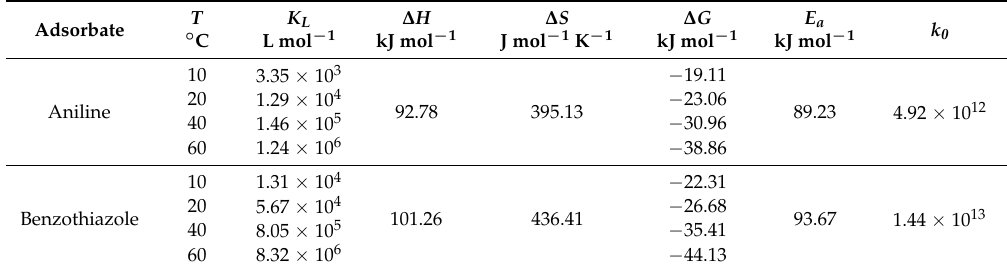
Table 5. Activation energy and thermodynamic parameters of aniline or benzothiazole onto TiO 2 .